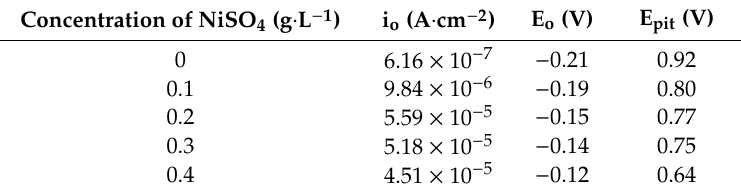
Figure 5. Potentiodynamic polarization curves of colored films formed by coloring solutions with different NiSO 4 concentrations in 3.5 wt % NaCl aqueous solution. Table 2. Electrochemical parameters of polarization curve for different colored specimens.